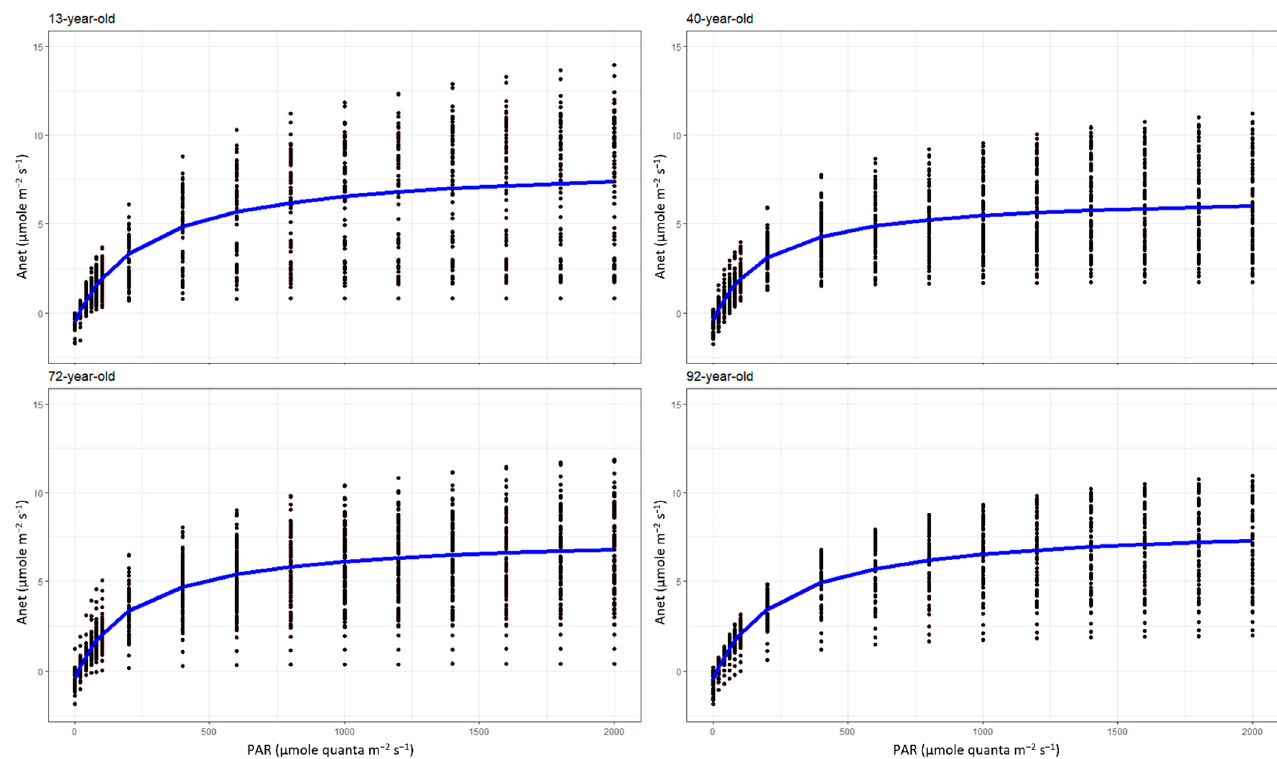
Figure A2. The composite (across all months) light response curve per plot.